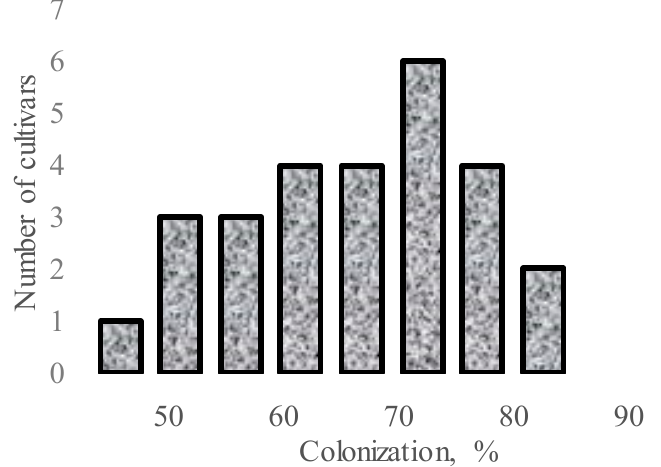
Figure 1. Varietal differences in A. fistulosum root colonization upon inoculation with G. fasciculatus (data re-elaborated from Tawaraya et al., 2001 [58]).